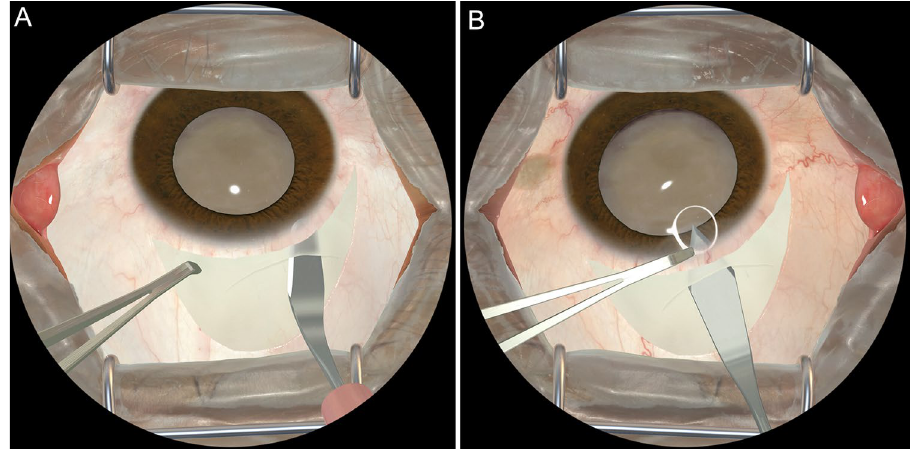
Figure 2. Surgeon’s view of the simulated surgery in the HelpMeSee Eye Surgery Simulator. ( A ) Depicts tunnel dissection with a crescent knife. ( B ) A keratome being used to enter the eye through the